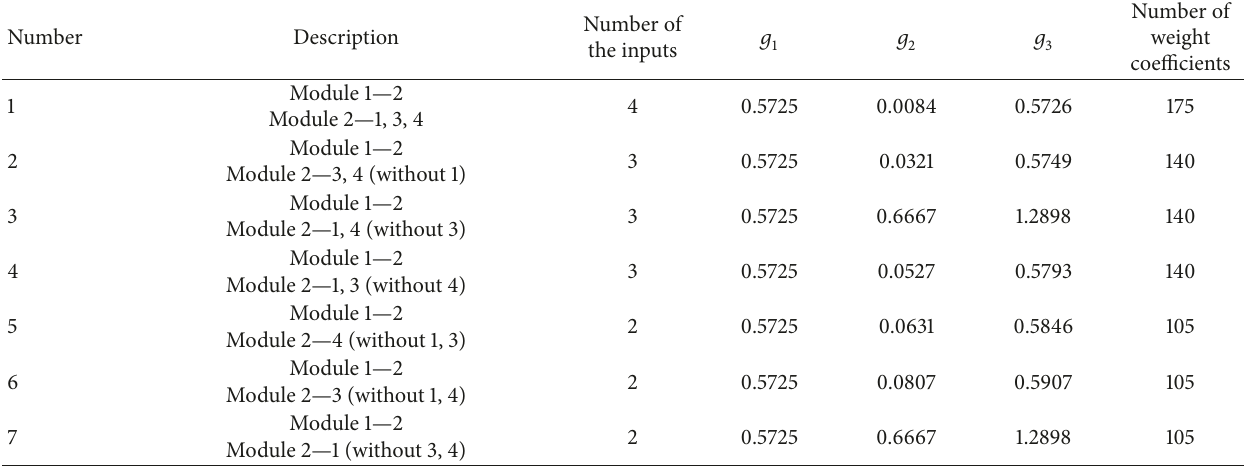
Table 8: Results from the simulations.